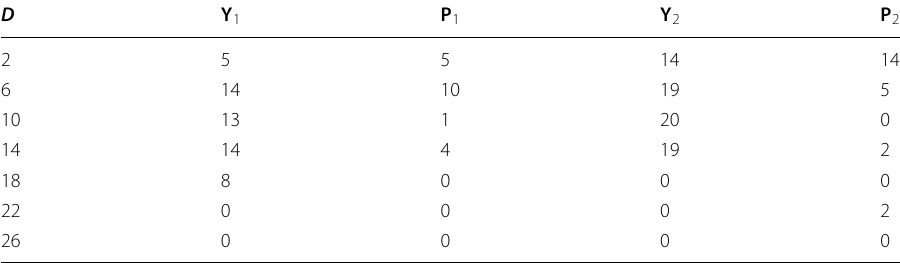
Table 3 Shortest path distances between the exact most central node and approximated most central node using pruning and the YTQ